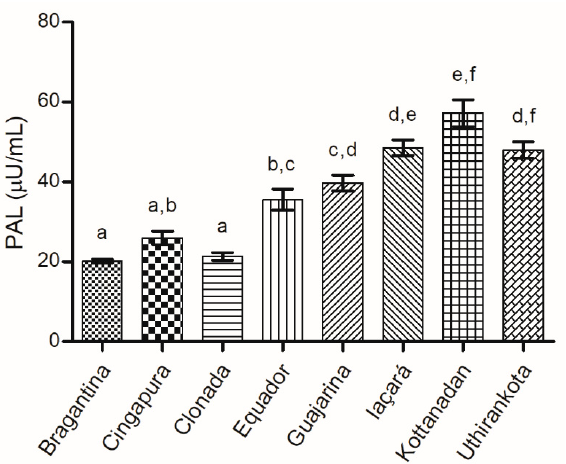
Figure 6. Enzymatic activity of PAL in the leaves of black pepper cultivars. a–f Different letters represent a statistically significant difference by Tukey’s test ( p < 0.05).